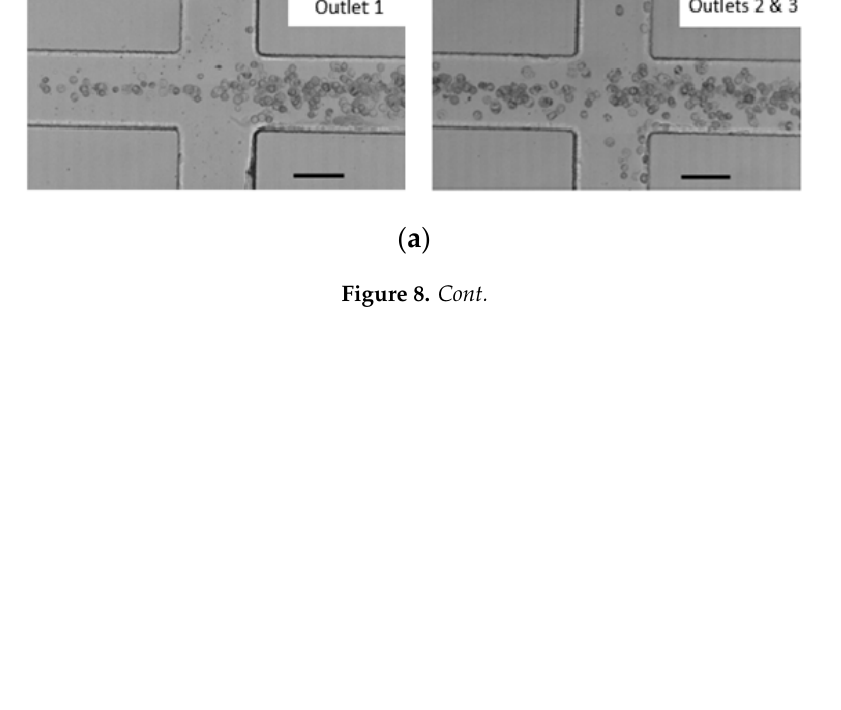
( b ) Figure 8. Representative results of the cell cycle synchronization. Flow conditions were 600 μ L·min − 1 , 1:4 ratio and σ = 0.21. ( a ) Bright field images show cells exiting through outlets 1 and 2. Scale bar is 100 μ m. ( b ) 4’,6-diamidino-2-phenylindole (DAPI) area analysis of cells shows increase of G1 phase in outlets 1 and 2 and an increase in G2 phase in outlet 3 as compared to the control. 4. Conclusions In conclusion, we have comprehensively shown the impact of flow rate, flow rate ratio and output resistance on the tunability of cutoff size and the separation quality of a continuous range of microparticles in a co-flow device. Both flow rate and flow rate ratio offer convenient ways to fine tune the cutoff size of a given co-flow channel for separation. The former is more effective in fine tuning larger sized particles while better efficiency is achieved at lower flow rate. The latter is important for tuning separation quality as smaller ratio giving more uniform initial particle positions. The resistance ratio provides the most significant tunability in terms of cutoff size. Consequently, this also has a large effect on the refinement of separation due to the large flexible range of cutoff sizes. Overall, our results show that a lower flow rate, flow rate ratio and a mid-level resistance ratio provides the best separation efficiency and quality of all three outlets. Testing the device with a typical mixture of single sized particles validated the cutoff size showing that the continuous particles can be used to predict performance of the device.